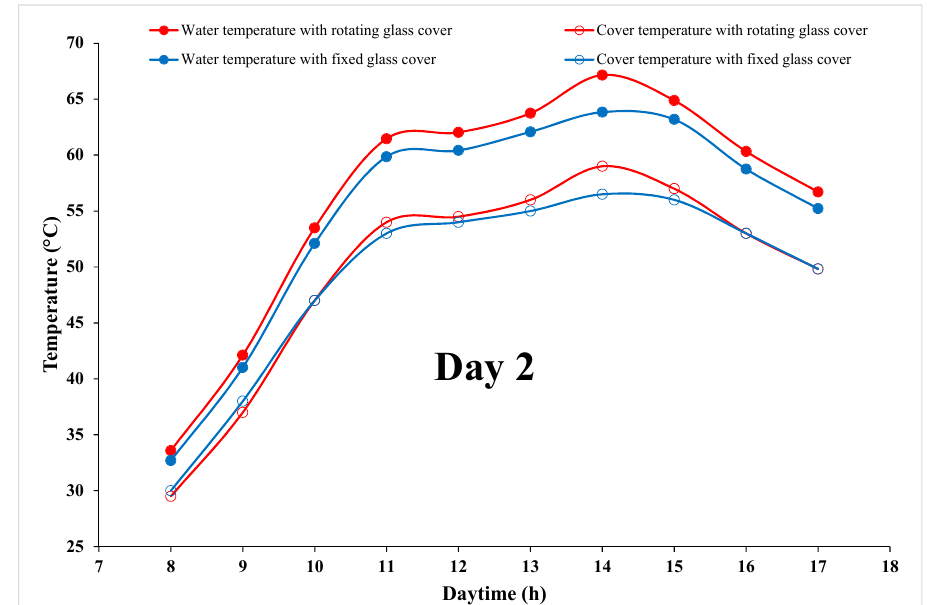
Figure 6. Water and cover temperature on 28 August 2021 (day 2), where the cylindrical cover is fixed or rotates.